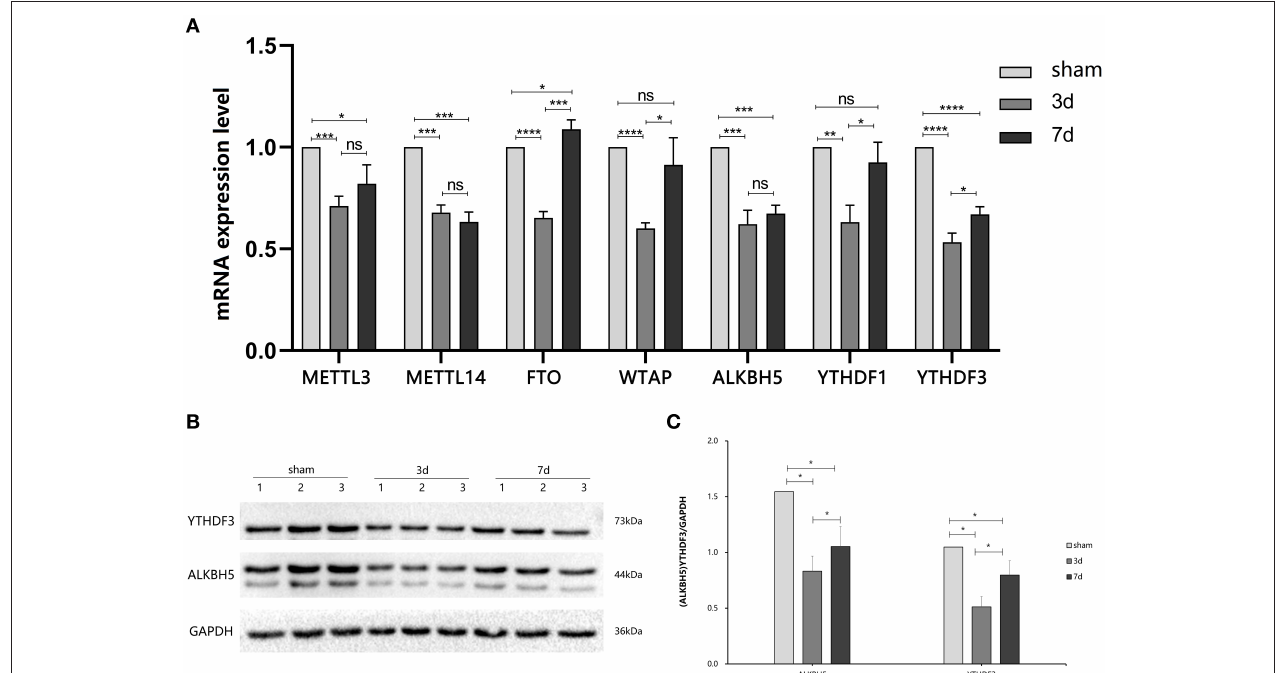
FIGURE 2 | Expression of m 6 A related enzymes between MCAO and sham groups. (A) The mRNA expression level of m 6 A writers (METTL3, METTL14, and WTAP), m 6 A erasers (FTO, ALBKH5), and m 6 A readers (YTHDF1, YTHDF3) were changed at 3d or 7d after MCAO compared with the sham, ( n = 6/group). (B,C) The protein YTHDF3 were significantly decreased in 3d group, while increased in 7d group, ( n = 6/group). * P < 0.05, ** P < 0.01,*** P < 0.001,**** P < 0.0001; ns, not significant.